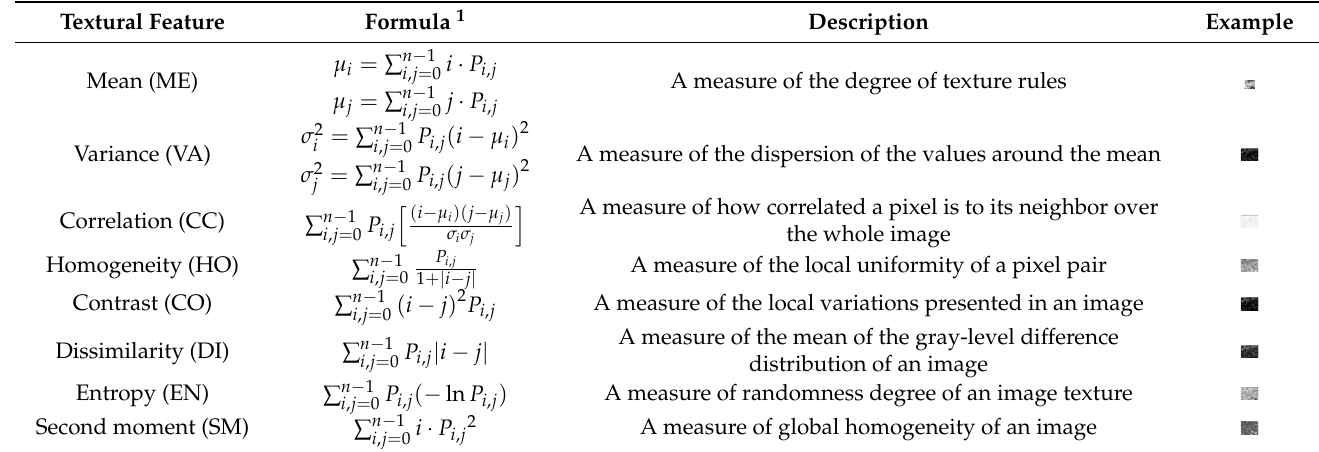
Table 2. Textural features extracted from gray-level co-occurrence matrix (GLCM) and their representations. Textural Feature Formula 1 Description